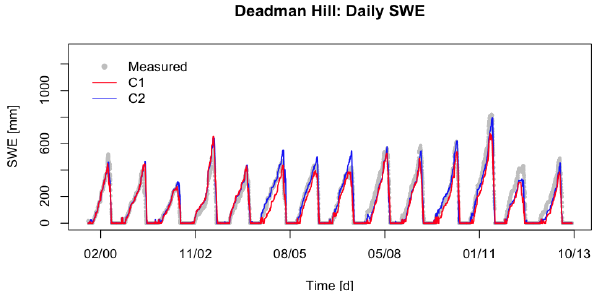
Fig. 4. Calibration and evaluation model results for the station- Figure 4. Calibration and evaluation model results for station- specificcalibrationtestinDeadmanHillstation:thegraydotsrep- specific calibration test at the Deadman Hill station: the gray dots resent the measured SWE, the solid red line represents the model C1(classicaltemperature-indexmodel)andthebluesolidlinerep- represent the measured SWE, the solid red line represents the model resentsthemodelC2(CazorziandDallaFontana). C1 (classical temperature index model) and the blue solid line rep- resents the model C2 (Cazorzi and Dalla Fontana). Formettaetal.: SnowwaterequivalentmodelingcomponentinNewAge-JGrass